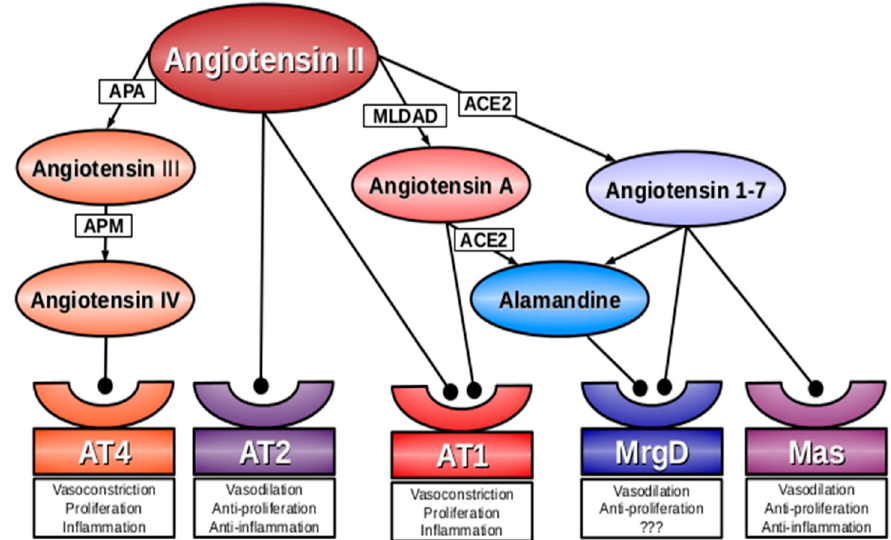
Figure 1. The position of the angiotensin A/alamandine/MrgD signaling pathway within the renin-angiotensin system. The “deleterious” molecules are marked in red/orange, the “protective” ones are marked in blue/purple. ACE2—angiotensin-converting enzyme type 2; AT1, AT2, AT3—angiotensin receptor type 1, 2 and 3, respectively, APA—aminopeptidase A; APM—aminopeptidase M; MLDAD—mononuclear leukocyte-derived aspartate decarboxylase.